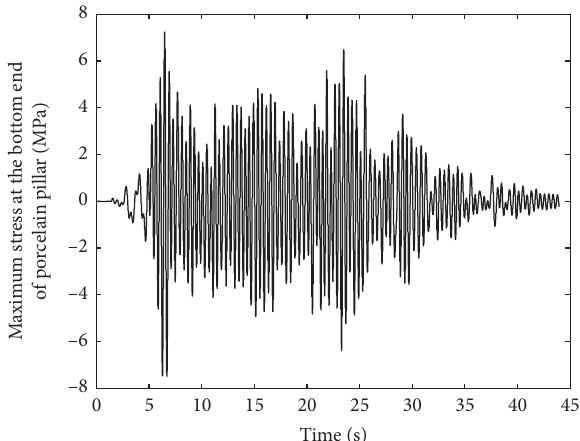
Figure 21: Maximum stress at the bottom of porcelain pillar ( a � 0.1g, η � 20,000).